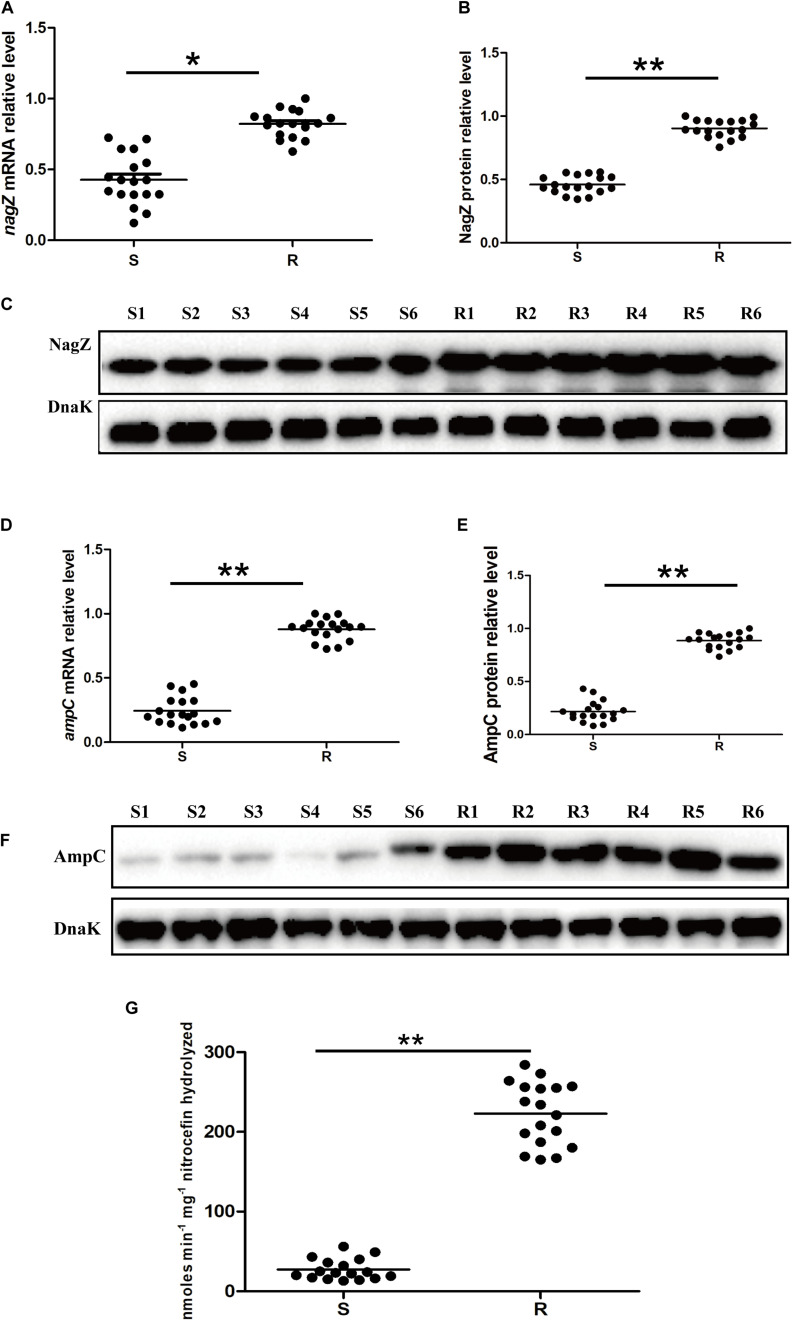
The expression levels of nagZ and ampC in Enterobacter cloacae (EC) isolated from clinical samples. (A) Quantification by reverse transcription-quantitative polymerase chain reaction (RT-qPCR) analysis of nagZ in susceptible and resistant EC isolates. (B) Quantitative analysis of the results of western blot (C), DnaK was used as an internal control. (C) Western blot analysis of nagZ protein expression in the susceptible and resistant EC. (D) RT-qPCR analysis of ampC at mRNA level in susceptible and resistant EC strains. (E) Quantitative analysis of the results of western blot (F), DnaK was used as an internal control. (F) Western blot analysis of ampC at protein level in susceptible and resistant isolates of EC. (G) AmpC β-lactamase activity (measured in nanomoles per minute per milligram nitrocefin hydrolyzed) were measured by nitrocefin hydrolysis assay. S, susceptible EC isolated from the clinical sample; R, resistant EC isolated from the clinical sample; S1, susceptible EC isolates number 1; R1, resistant EC isolates number 1, and so on. *P < 0.05 and **P < 0.01 indicate statistically significant and statistically highly significant, respectively.